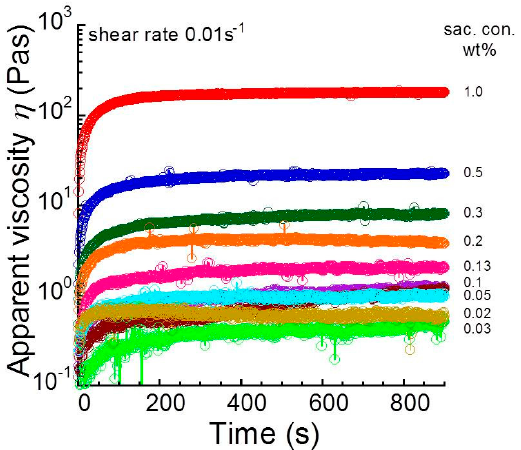
Figure 3. Time profiles of apparent shear viscosity for sacran aqueous solutions with various sacran concentrations at a shear rate of 0.01 s − 1 .